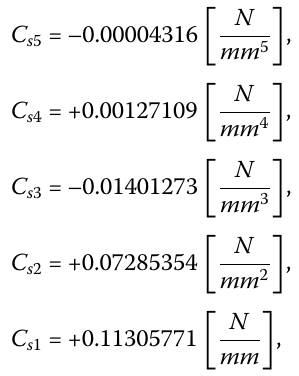
with the not well-defined position of the kink. Therefore, a polynomial fit was tried as a better and more soft approach. For an acceptable result we have to choose a fifth order polynomial of